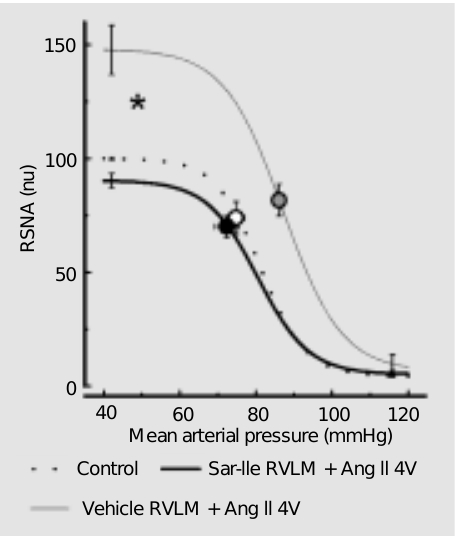
Figure 7. Average mean